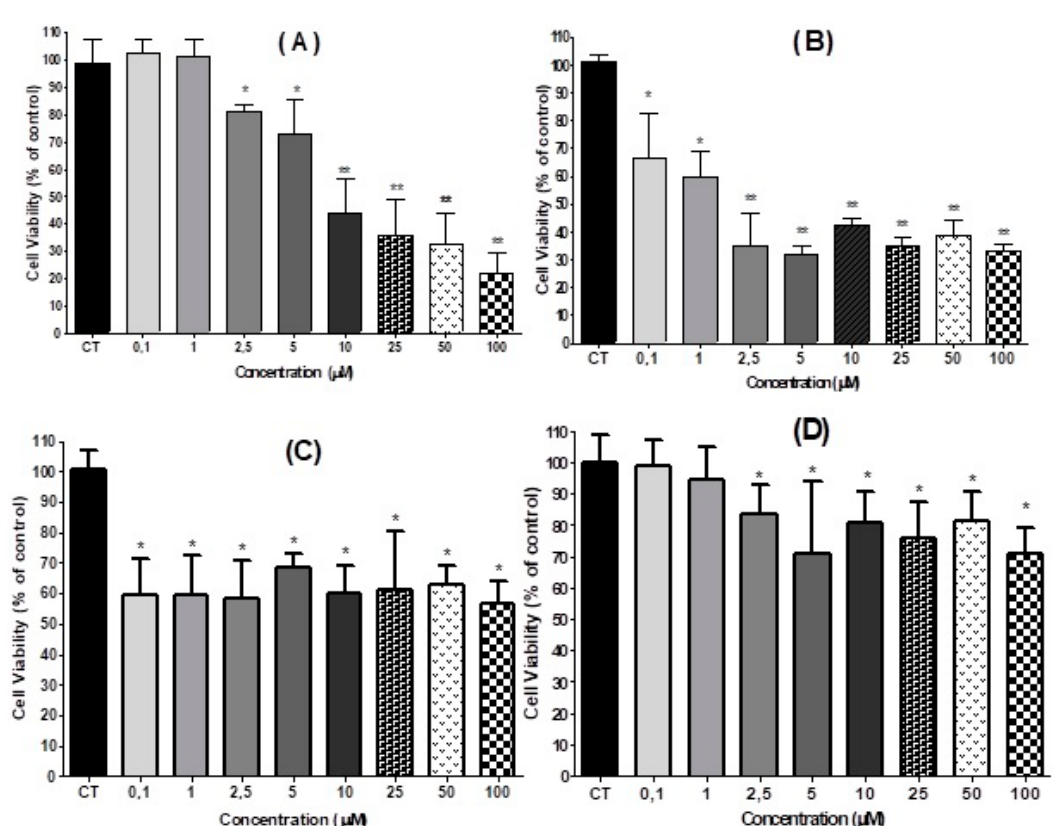
Figure 2. Effect of 3,4-DHPAA ( A ), FA ( B ), p -CoA ( C ) and VA ( D ) on viability (mean ± SD) of HT-29 cells 24 h after incubation. Significant differences between the untreated cells (CT) and those incubated with the respective acids (0.1 µM to 100 µM) were compared by the One-way ANOVA test, with Tukey post-test (* p < 0.05; ** p < 0.01).